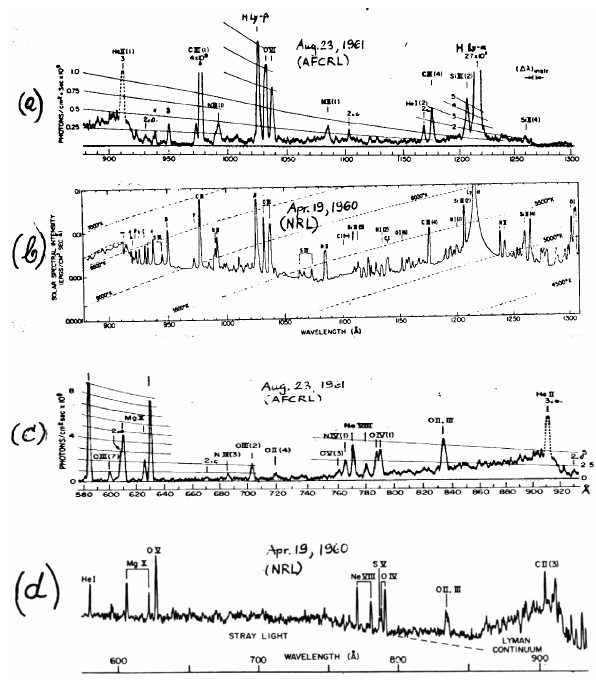
Figure 9. An intercomparison of photoelectric recordings with pho- tographical densitometer records of solar emissions in the EUV spectral region from 130 to 58nm (Tousey, 1963, copyright permis- sion granted by Springer; Hinteregger, 1961b, copyright